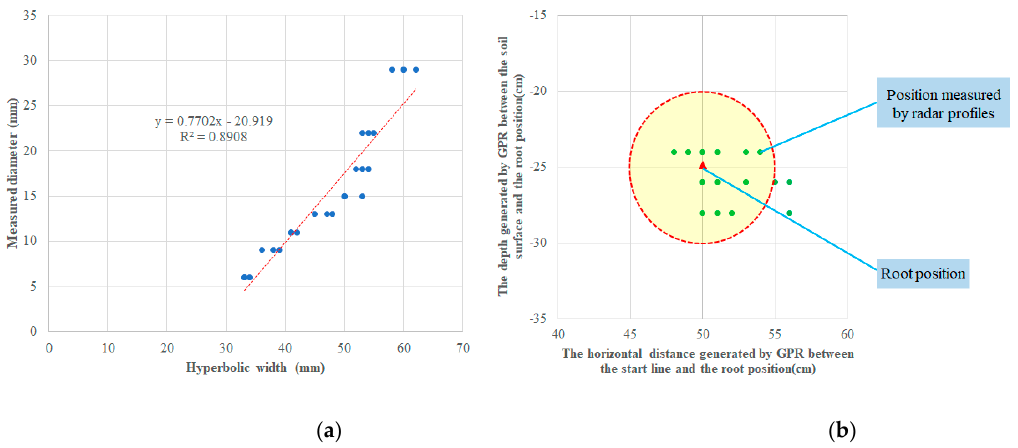
Figure 7. Evaluation of root diameter and root position. ( a ) Relationship between measured root diameter and width of the hyperbola. ( b ) Root locations measured by the GPR (the actual root position is indicated by the red triangle).